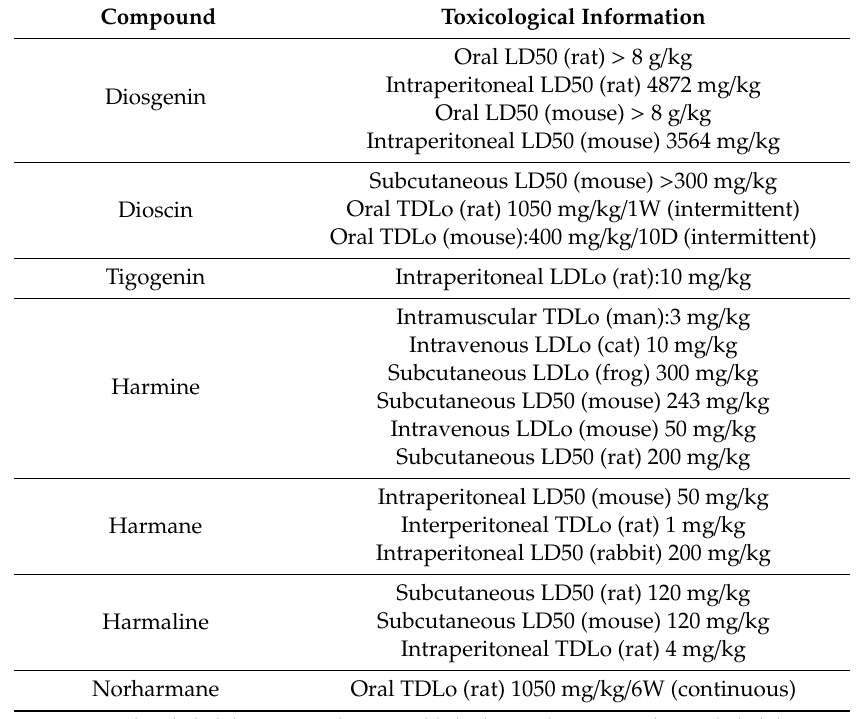
Table 5. Toxicological information of some compounds from the U.S. National Library of Medicine